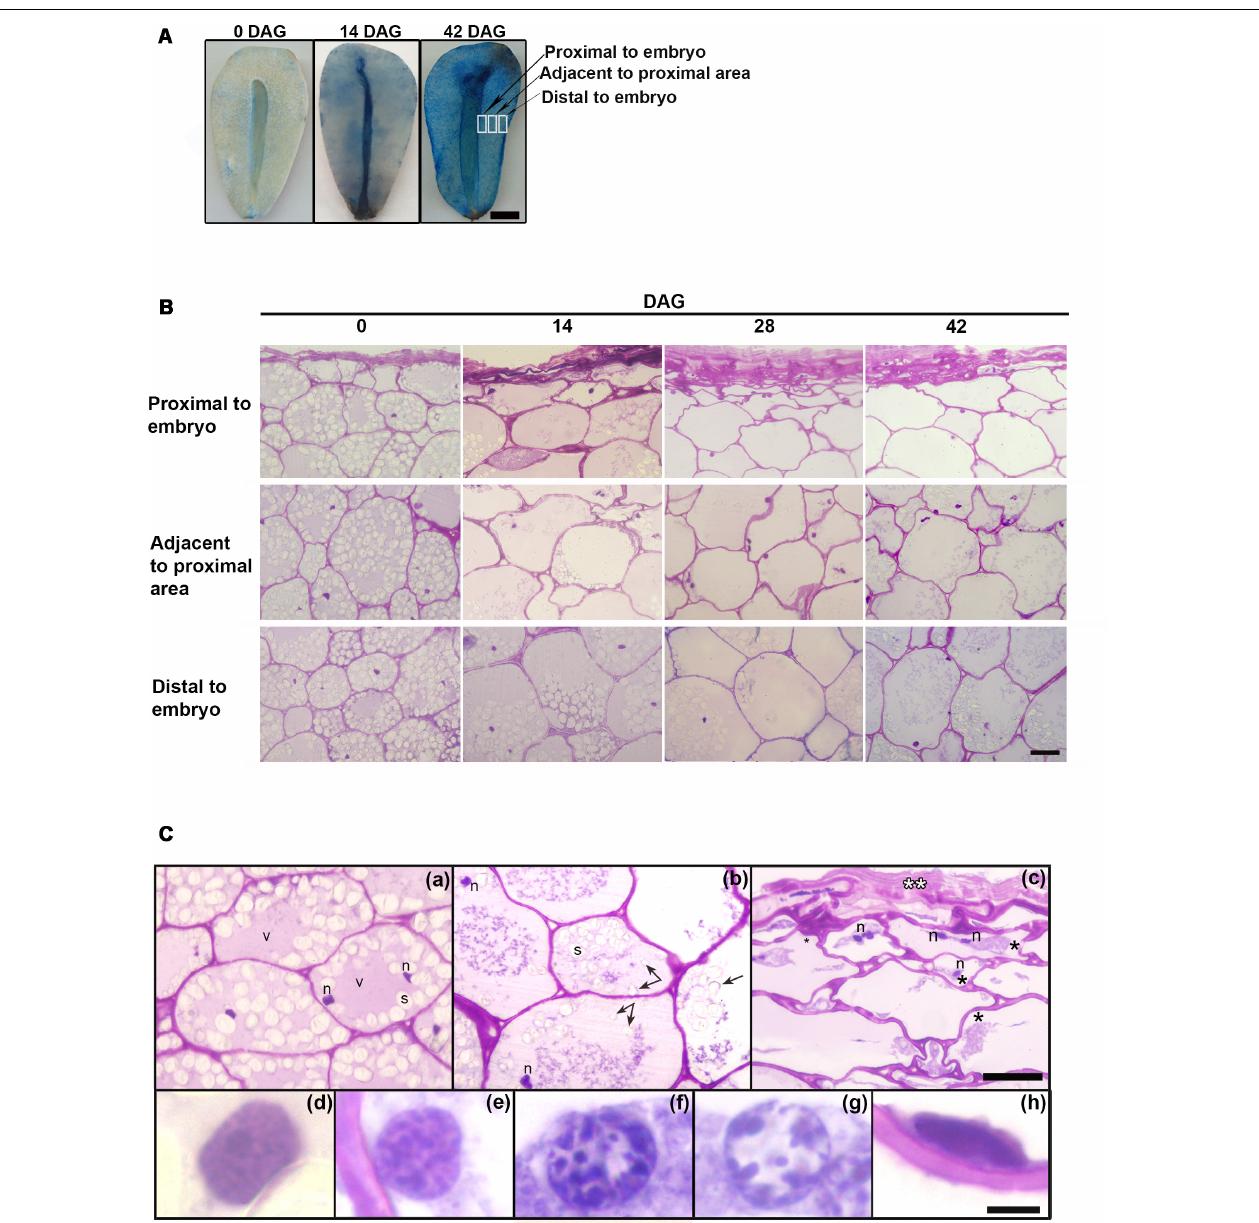
FIGURE 1 | (A) Evans Blue staining at 0 and 42 DAG in the megagametophyte after extraction of the embryo. In each case the figure is a representative result of observation of at least 6 seeds. Scale bar = 0.5 cm (B) Changes occurring from the proximal to distal zones in the megagametophyte, at 0, 14, 28, and 42 DAG. Scale bar: 50 µ m. (C) In detail, megagametophyte tissue (14 DAG). (a) , Distal section of the tissue; (b,c) , Adjacent to proximal sections; in c collapsed cell area. (Ca,c) , some cells show two nuclei. (d–h) , Progressive changes in nuclear morphology. The black asterisk indicates plasmolysis, the double white asterisk indicates crushed cells, and the black arrow indicates amyloplast discharged into central vacuole. Scale bar: (a–c) = 50 µ m, (d–h) = 5 µ m. Abbreviations: n , nucleus; v , vacuole; s , starch. Each image is a representative result of observation of at least 30 semi-thin sections of megagametophyte tissue at different